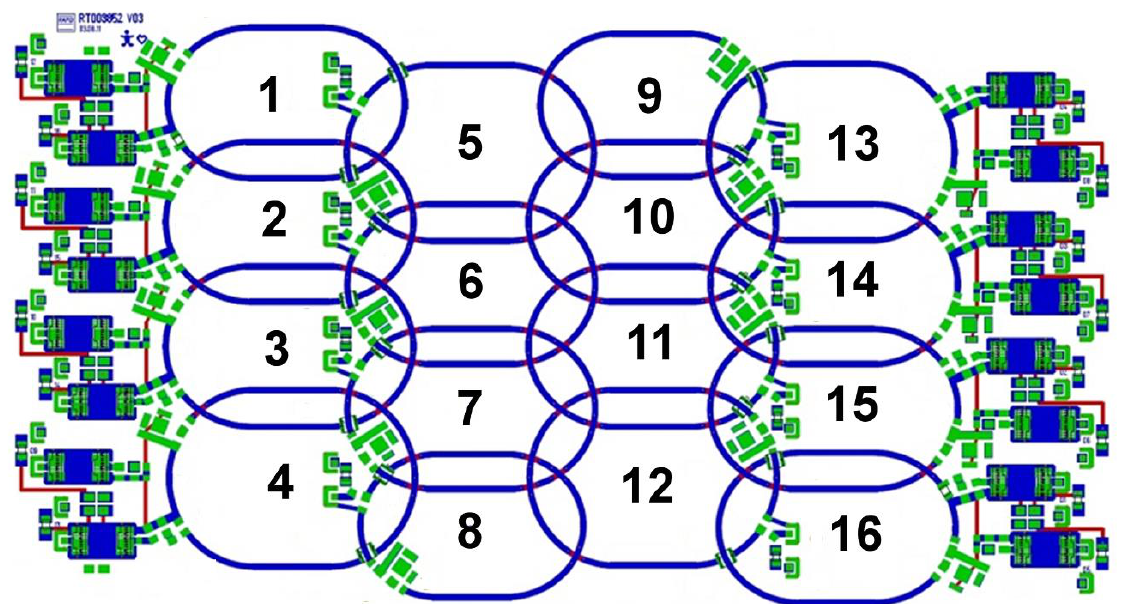
Figure 11. Phased-array coil structure. Reprinted by permission from Frijia et al., Journal of Medical and Biological Engineering 2016 [68].